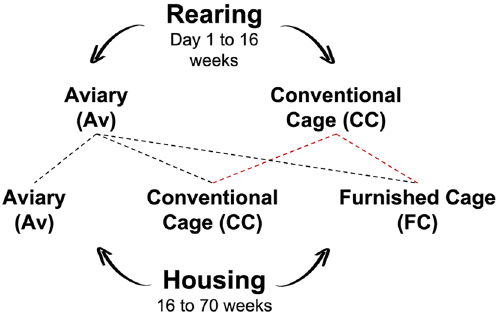
Figure 1. (From Peixoto et al. 19 ). Experiment 1. The combination of maternal rearing and housing experiences formed five treatment groups: Trt1 (Av × Av), Trt2 (CC × CC), Trt3 (Av × CC), Trt4 (CC × FC), Trt5 (Av × FC). This was repeated for two cohorts of hens. Since pullets reared in cages have difficulty adapting to aviary housing, only pullets reared in aviaries were transferred to adult aviary